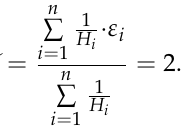
Table 4. Estimated parameters of the complex test model.